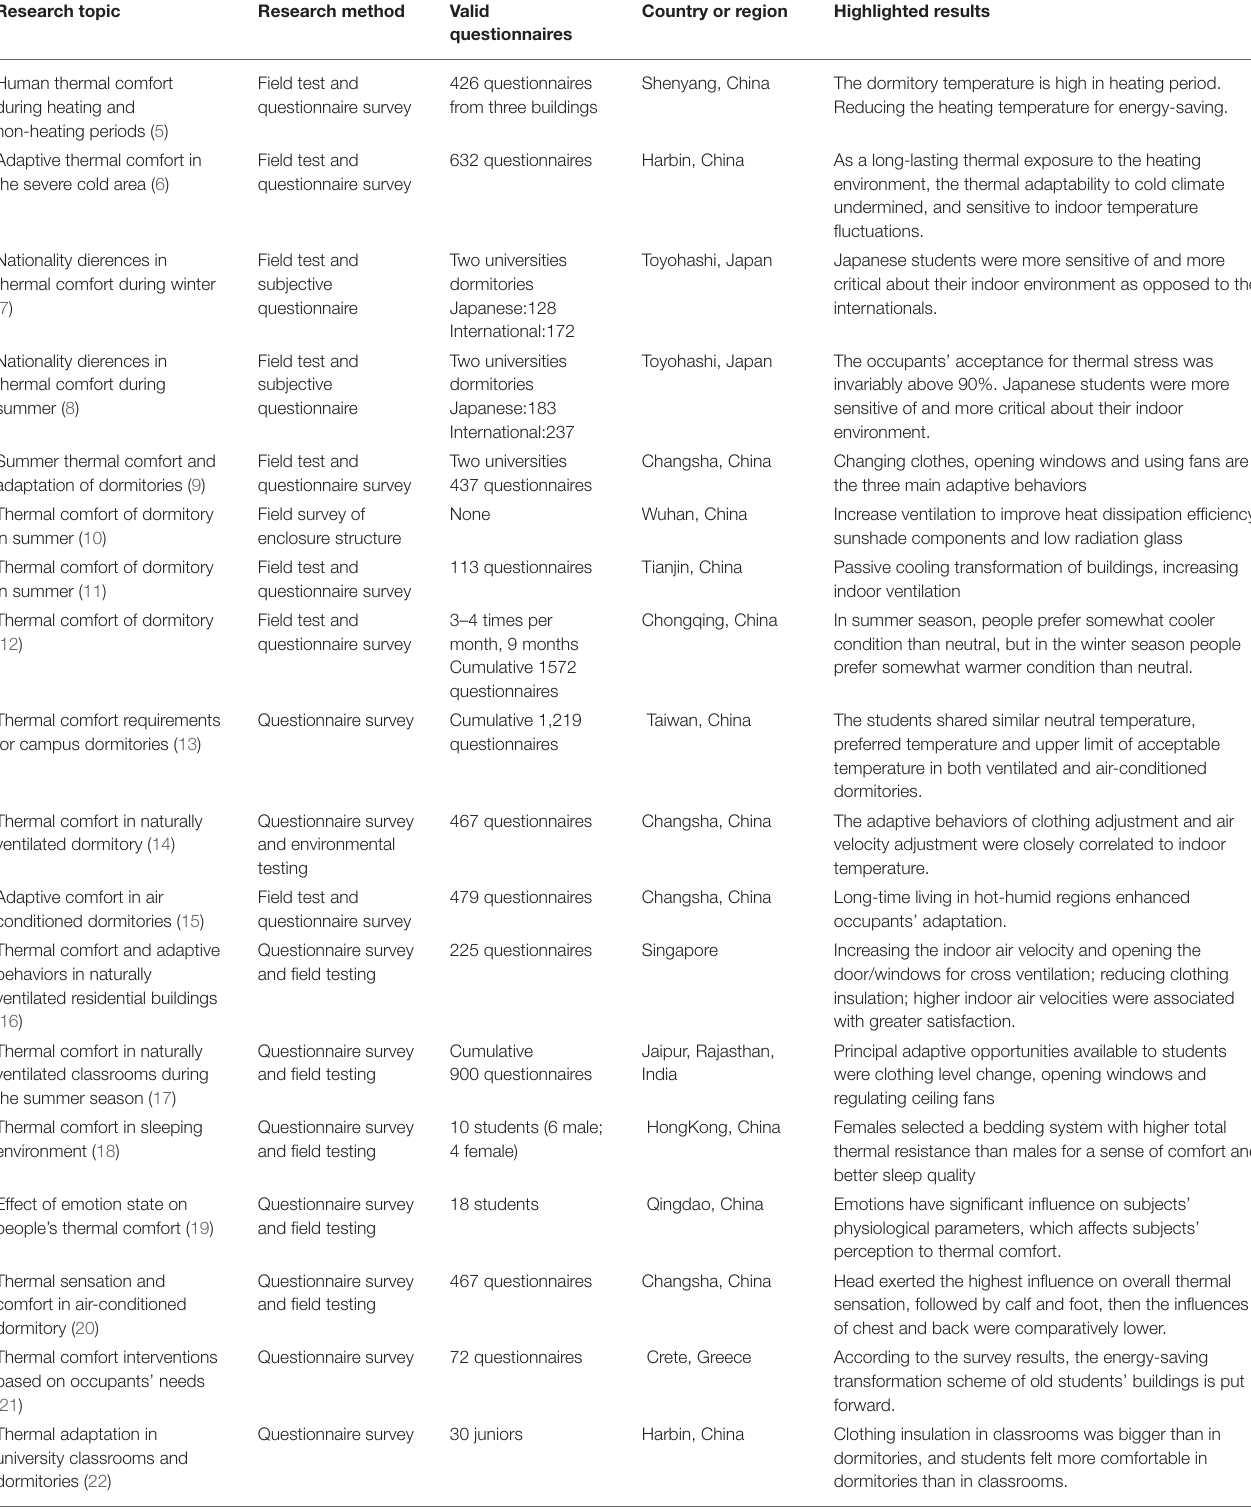
TABLE 2 | Literature review on thermal comfort of university dormitories or